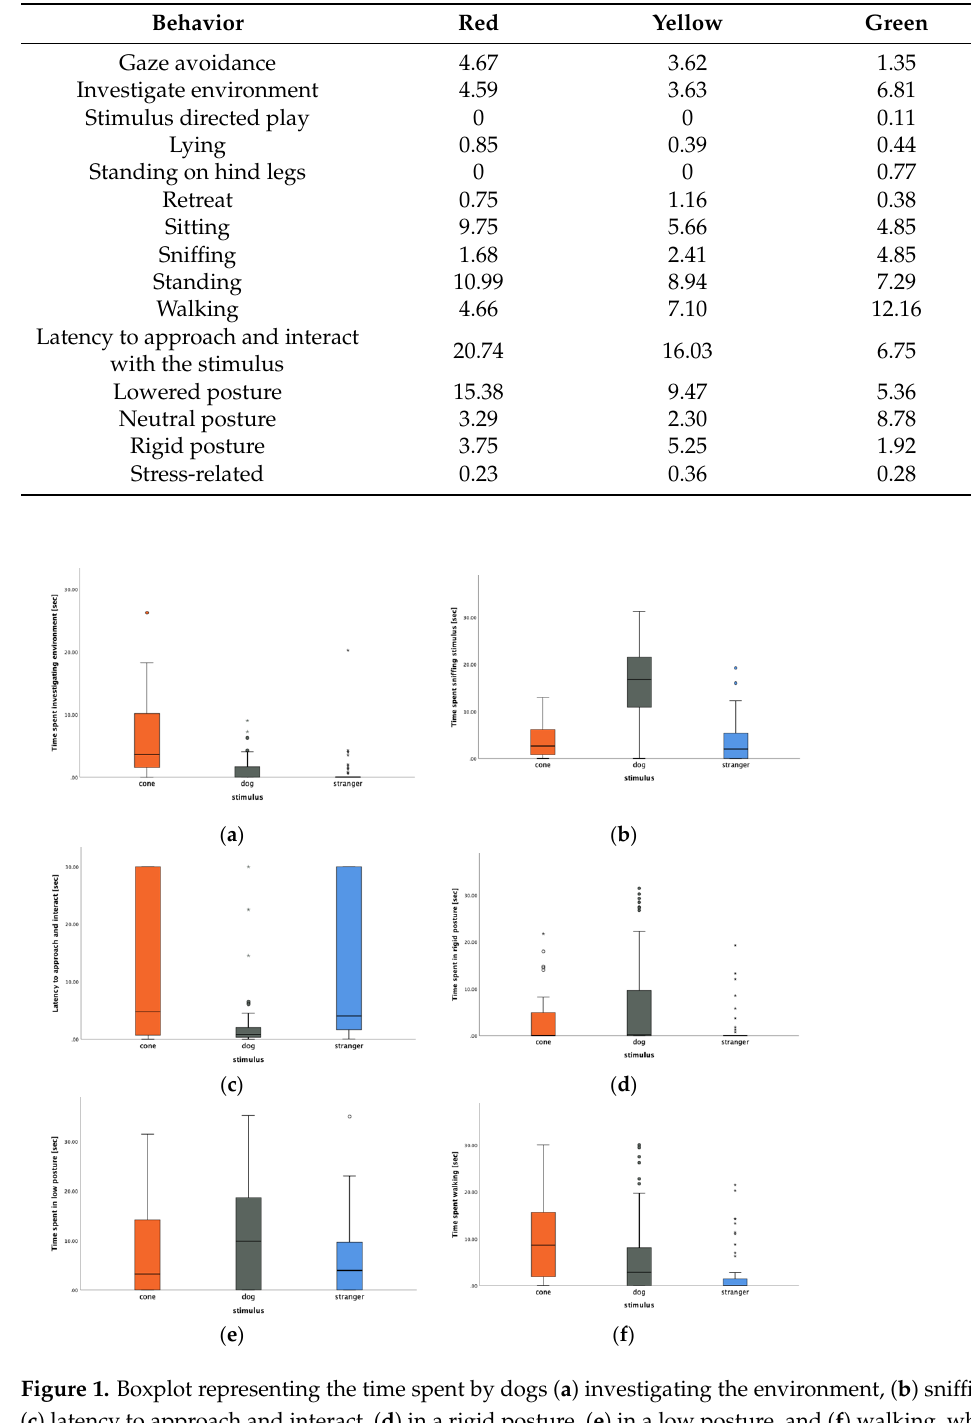
Table 4. Cross tabulation analysis for red, yellow, and green categories (based on [10]) for key behaviors. Values in the table represent the average duration in seconds spent in the listed behavior when subjects were exposed to the cone stimulus.